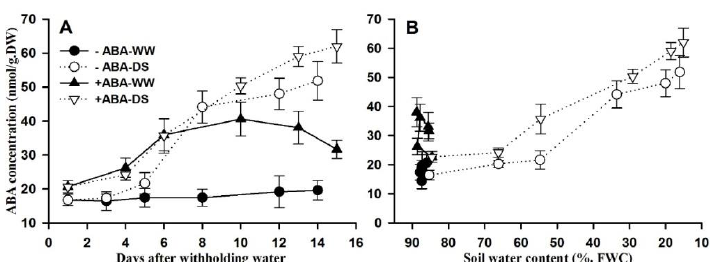
Figure 2. Changes in leaf ABA concentration over time (days) after withholding water ( A ) and with soil water content ( B ) in the soybean cultivar Jindou 19 (JD) treated with (+ABA) and without (−ABA) 10 µM exogenous ABA. Values are means ± SE ( n = 3).